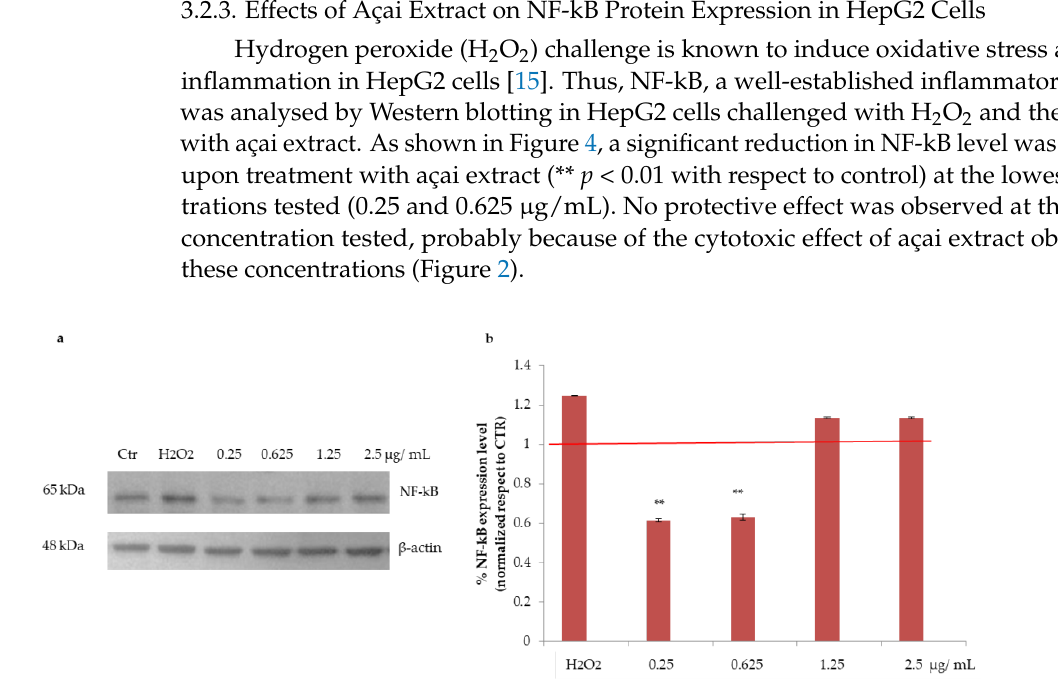
Figure 4. Effect of açai extract on nuclear NF-kB levels. ( a ) Western blot analysis of NF-kB levels and its relative densitometric analysis ( b ). The red line represents untreated cells. β -actin was used as an internal standard. Data shown are the means ± S.D. of independent experiments (n = 3). ** indicates p < 0.05.